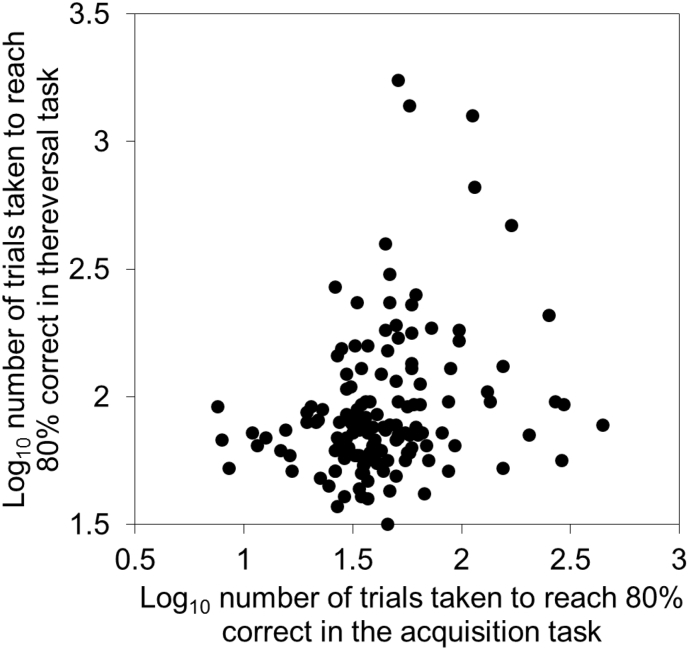
The relationship between the speeds of learning of an individual in an acquisition task and its reversal based on the discrimination of blue and green cues. Speed of learning is measured by the number of trials taken to reach a probability of being 80% correct, derived from learning curves. (For interpretation of the references to colour in this figure legend, the reader is referred to the web version of this article.)